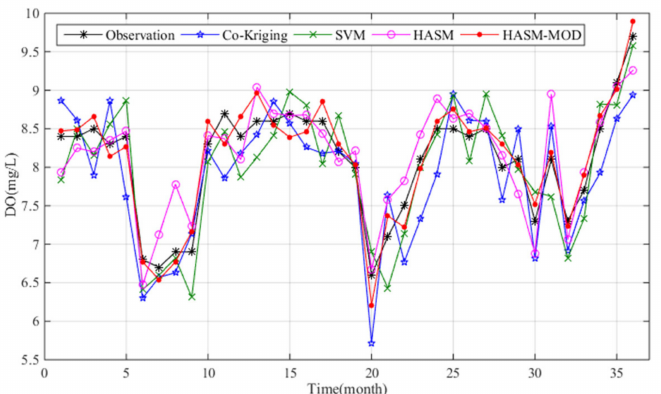
Figure 8. Comparison of the results of different methods with the observations at the Outlet_A station from January 2015 to December